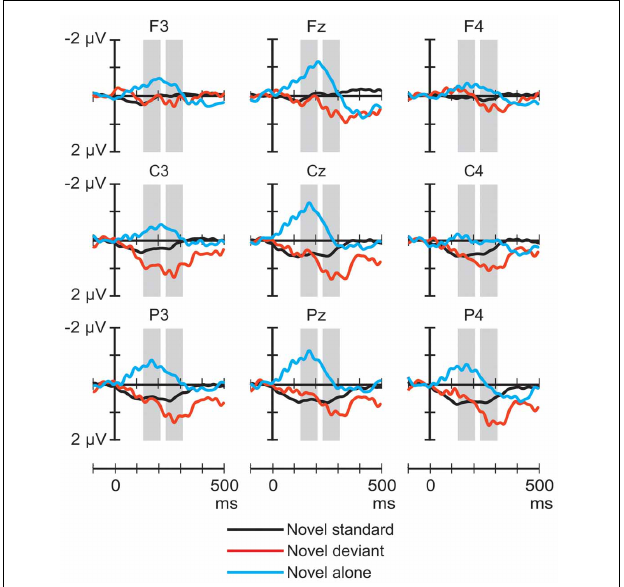
FIGURE 2 | Group-average ( n = 23) ERP responses elicited by the pure tones in the novel-deviant (tone standard; black line), and novel-standard (tone deviant; red) conditions at frontal, central, and parietal scalp locations. Amplitude measurement windows are indicated by gray